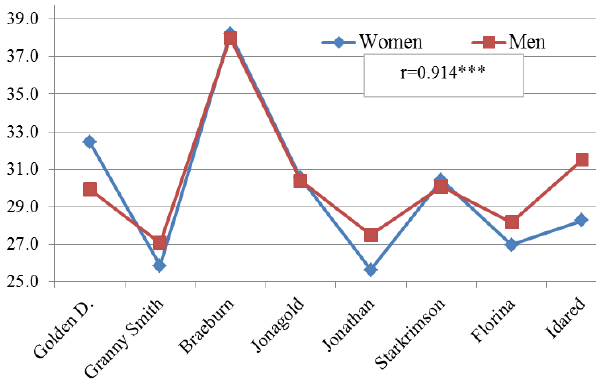
Fig. 9. Correlation based on tasters’ gender among quality traits marks in